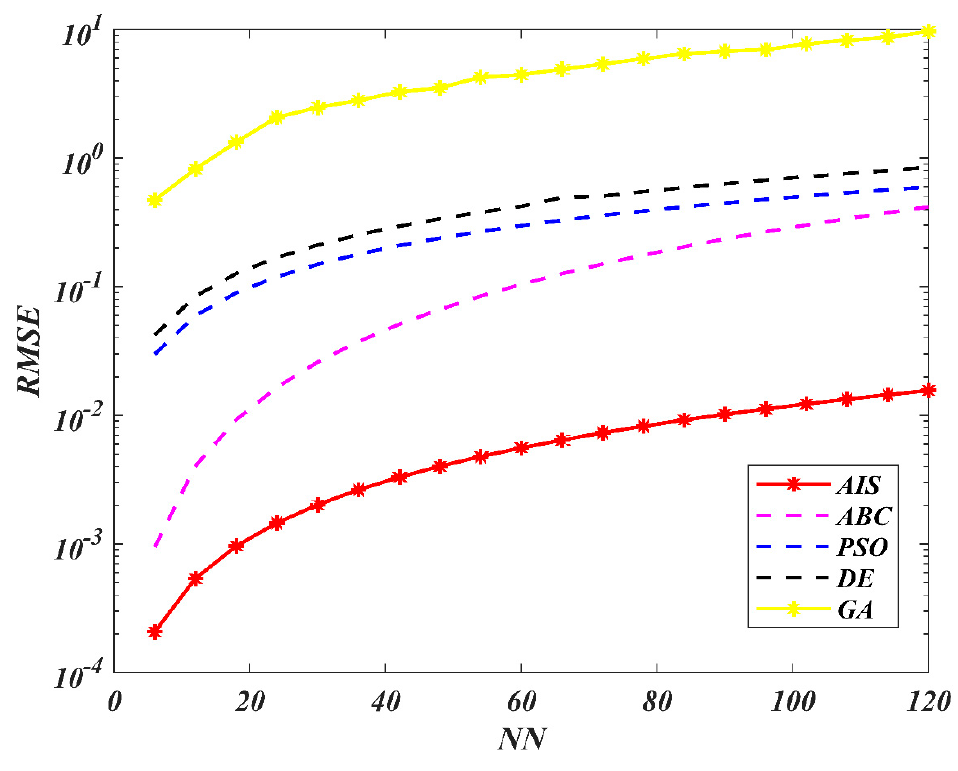
Figure 15. RMSE Evaluation for Congressional Voting Records.